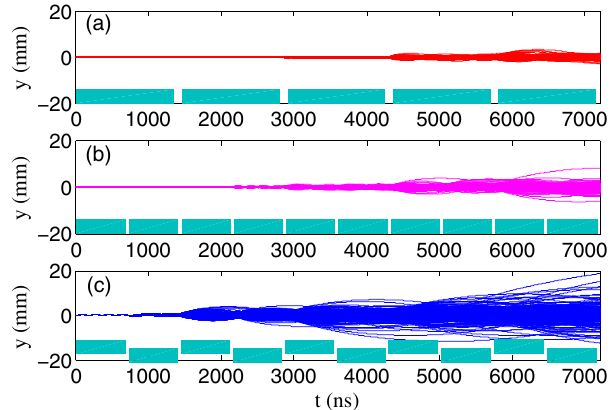
FIG. 5. The oscillation amplitude of ions with respect to the circulation time in the SSRF storage ring, tracking 5 turns. (a) 1 bunch train with 700 bunches followed by a 20 bunch empty gap; (b) 2 bunch trains with 350 bunches each, separated by a 10 bunch empty gap; (c) two spatially separated bunch trains of 350 bunches each, separated by a 10 bunch empty gap, run at different closed orbits with displacement 200 μ m at the observation point.